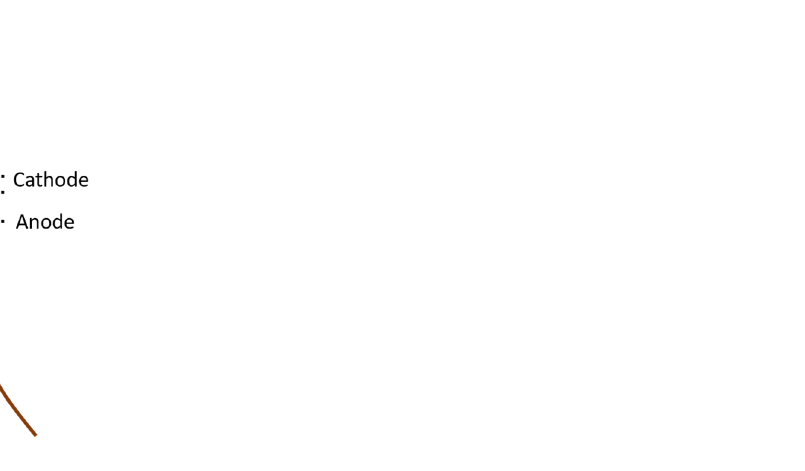
Figure 11. Various enzyme immobilization techniques for enzyme-based biofuel cells (EBFCs).